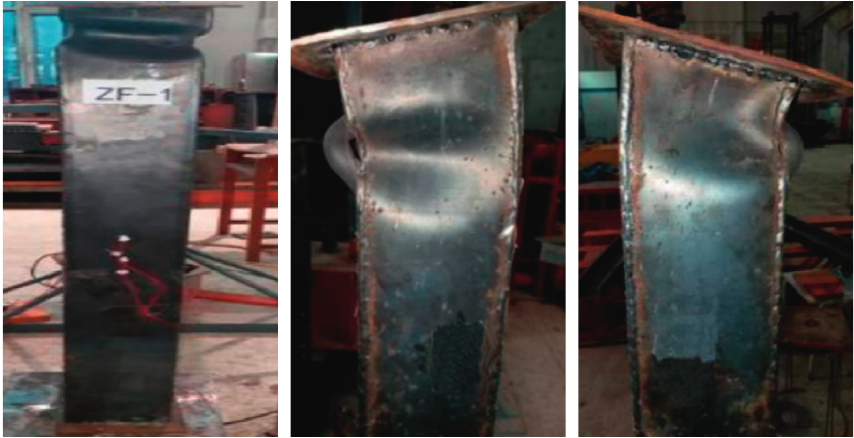
Figure 23: ZF-1 failure mode.